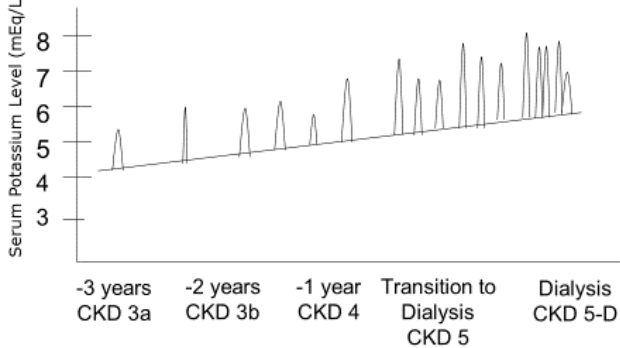
Figure 3. Acute on chronic and recurrent hyperkalaemia episodes by stages of chronic kidney disease (CKD). Special attention must be paid to avoid excess potassium intake, but together with maintenance